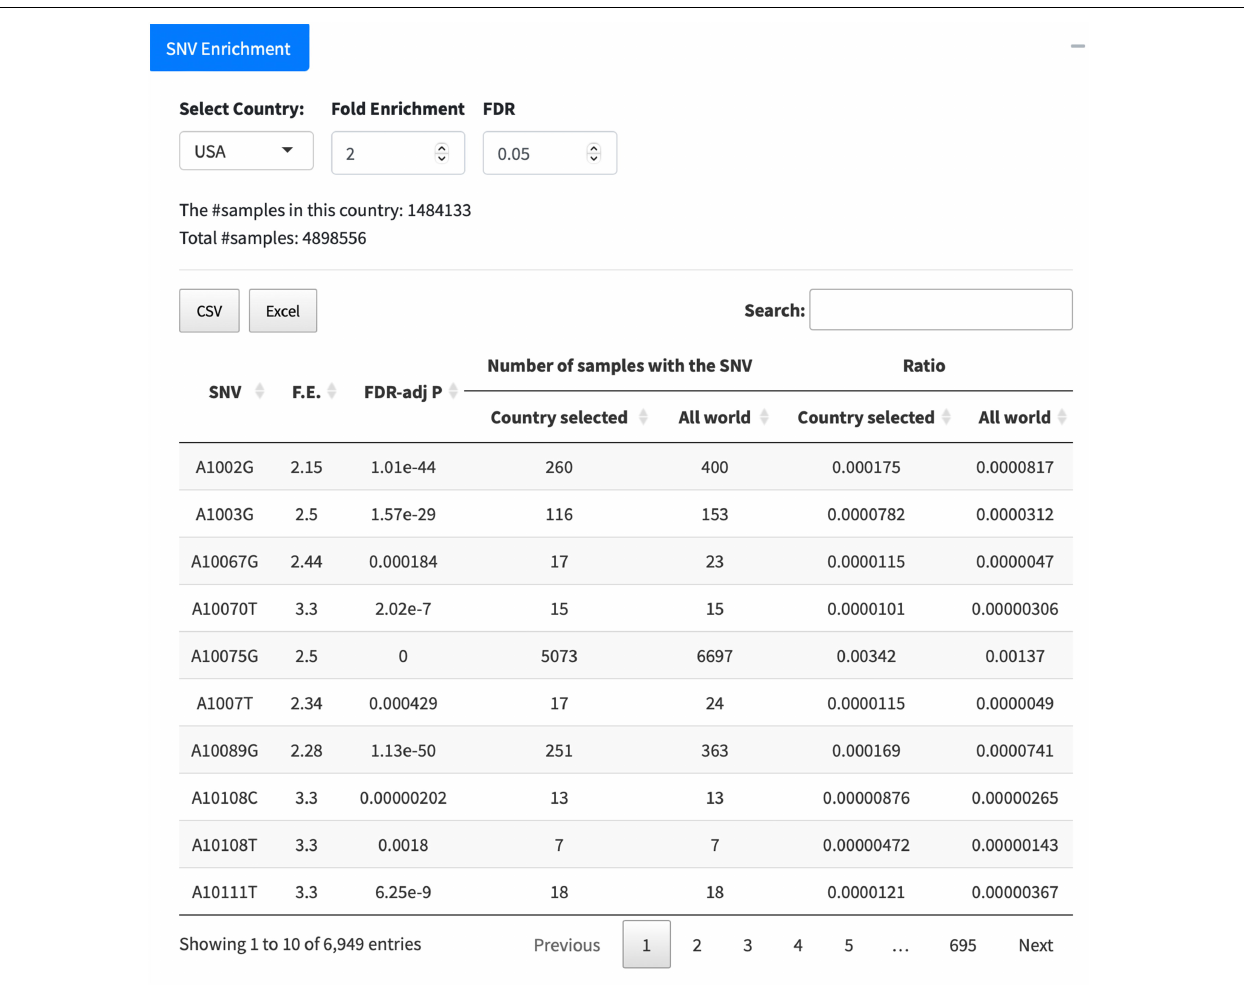
FIGURE 5 | Function of “SNV Enrichment.” The United States is taken as an example to list SNVs significantly [false discovery rate (FDR) < 0.05] enriched (F.E. > 2) in the